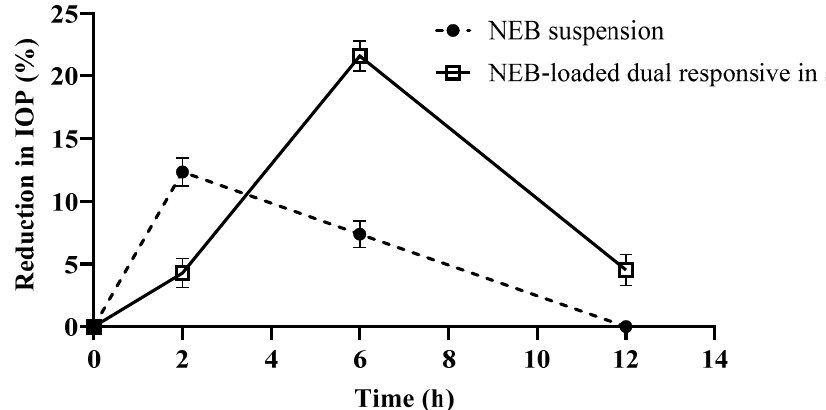
Figure 11. Percentage reduction in intra-ocular pressure [ ∆ IOP (%)] versus time profiles obtained following ocular administration of an NEB suspension and optimized NEB-loaded dual-responsive in situ gel at a drug dose of 0.05 mg/kg in male New Zealand white rabbits ( n = 6).